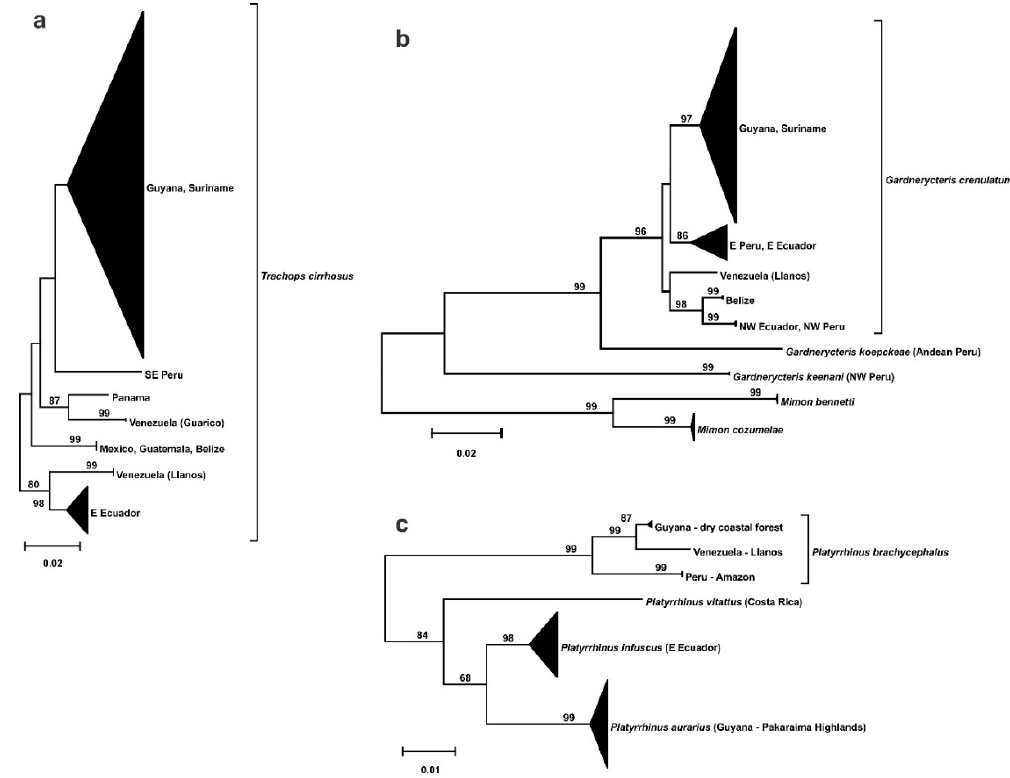
Figure 5. DNA barcoding trees of bat species with phylogeographic structuring of distinct lineages for populations from the Venezuelan Llanos in the states of Amazonas and Bolivar: ( a ) Trachops , ( b ) Gardnerycteris , and ( c ) Platyrrhinus .